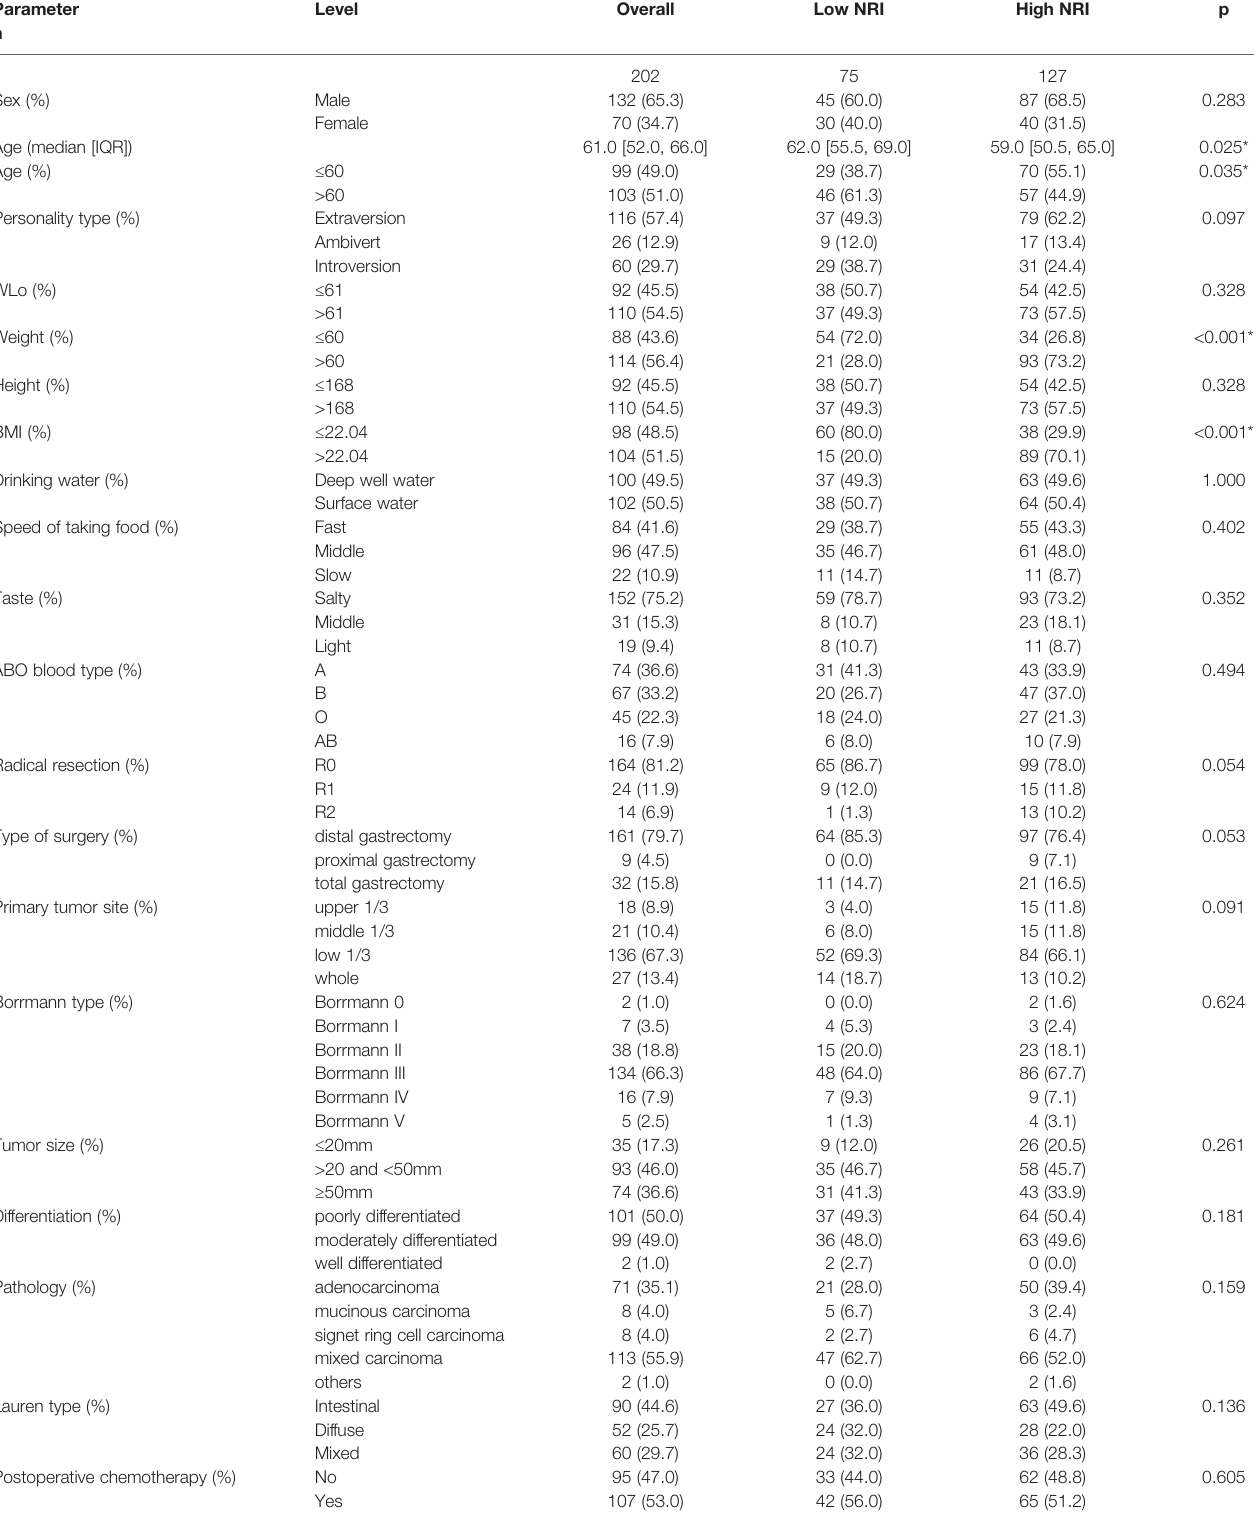
TABLE 1 | Association of NRI and patient characteristics. Parameter